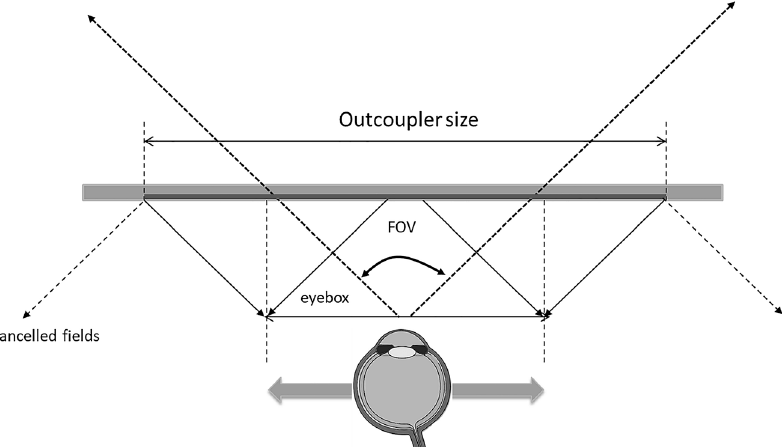
Figure 32: Eyeboxand FOV dictate the size of the out-coupler